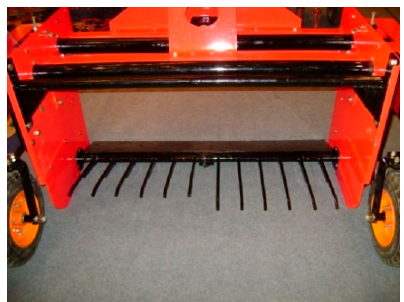
Figure 8. MAEC (Modern Agricultural Equipment Co. Ltd) sweet potato lifter (Photo: Brian Sims).